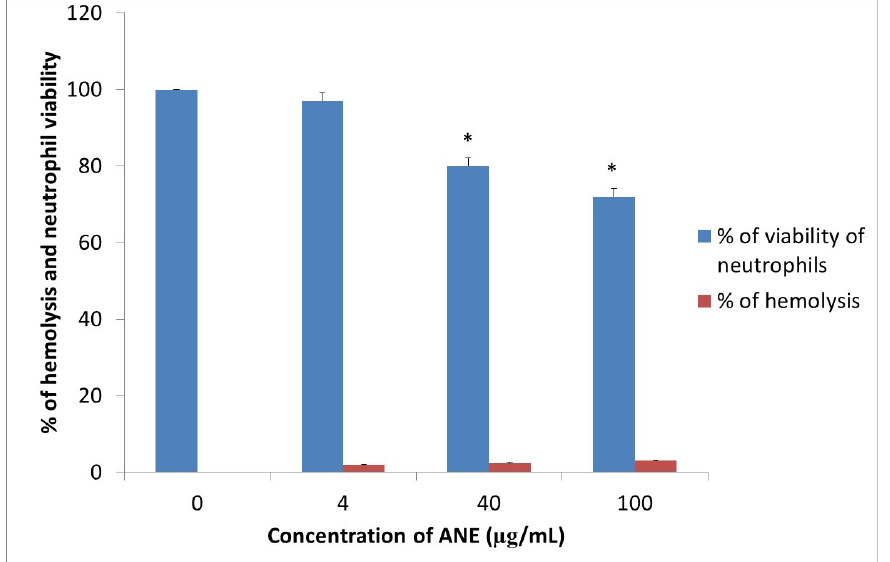
Figure 3. Test of potential cytotoxic and hemolytic ANE activity against host cells (neutrophils and erythrocytes, respectively). ANE was used at concentrations of 4, 40, and 100 μ g/mL. Dose-dependent reduction in viability and increased hemolysis were observed (* p < 0.05 compared to 0 μ g/mL).